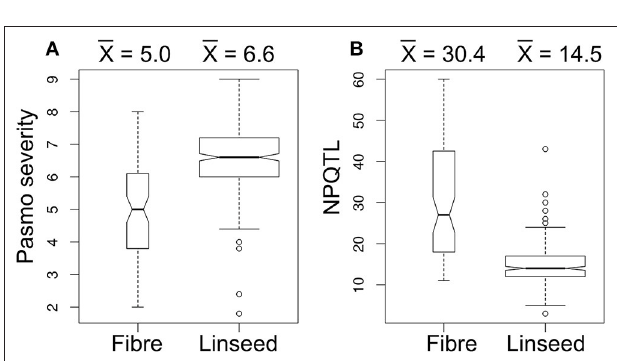
FIGURE 5 | Box plots of pasmo severity (A) and the number of QTL with positive-effect alleles (NPQTL) (B) in relation to